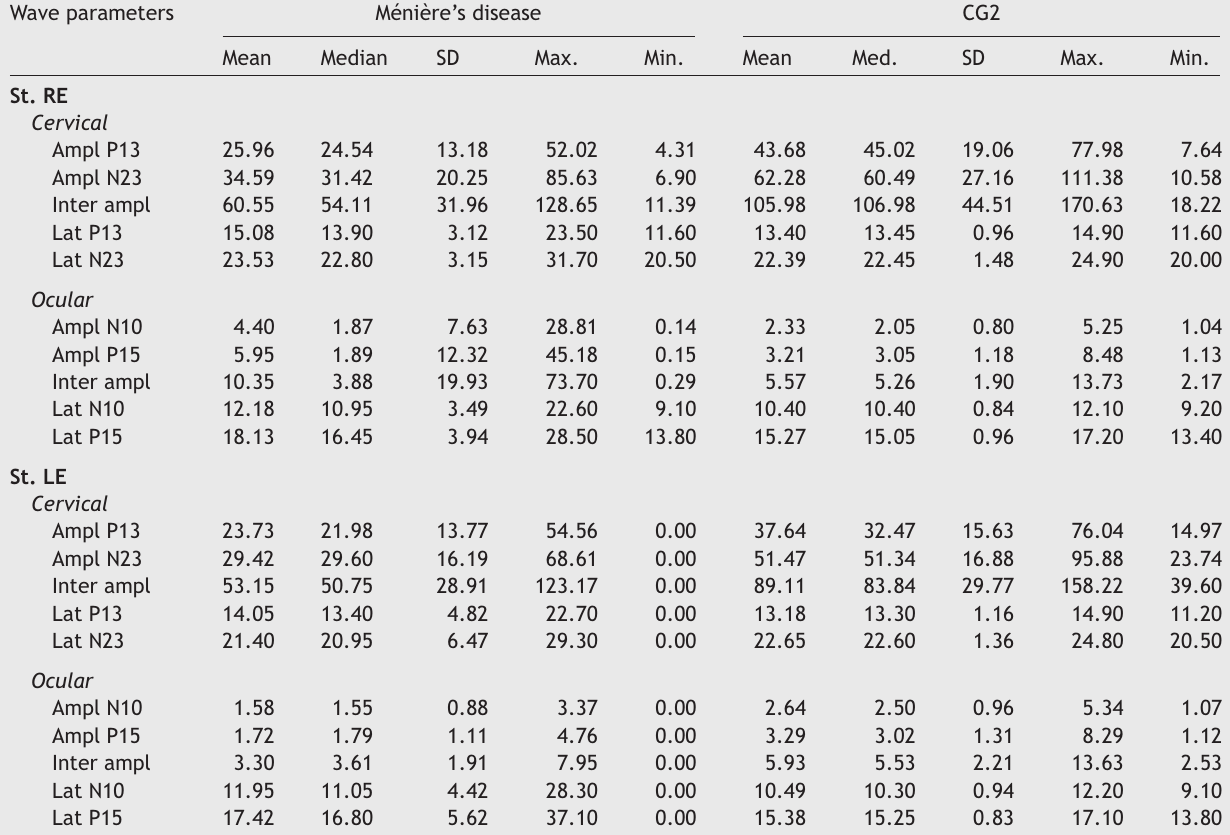
Table 2 Measures of central tendency, dispersion, and position for latency (ms) and amplitude ( (cid:2) V) for combined cervical and ocular VEMP for individuals with Ménière’s disease and individuals in the control group (CG2). Wave parameters